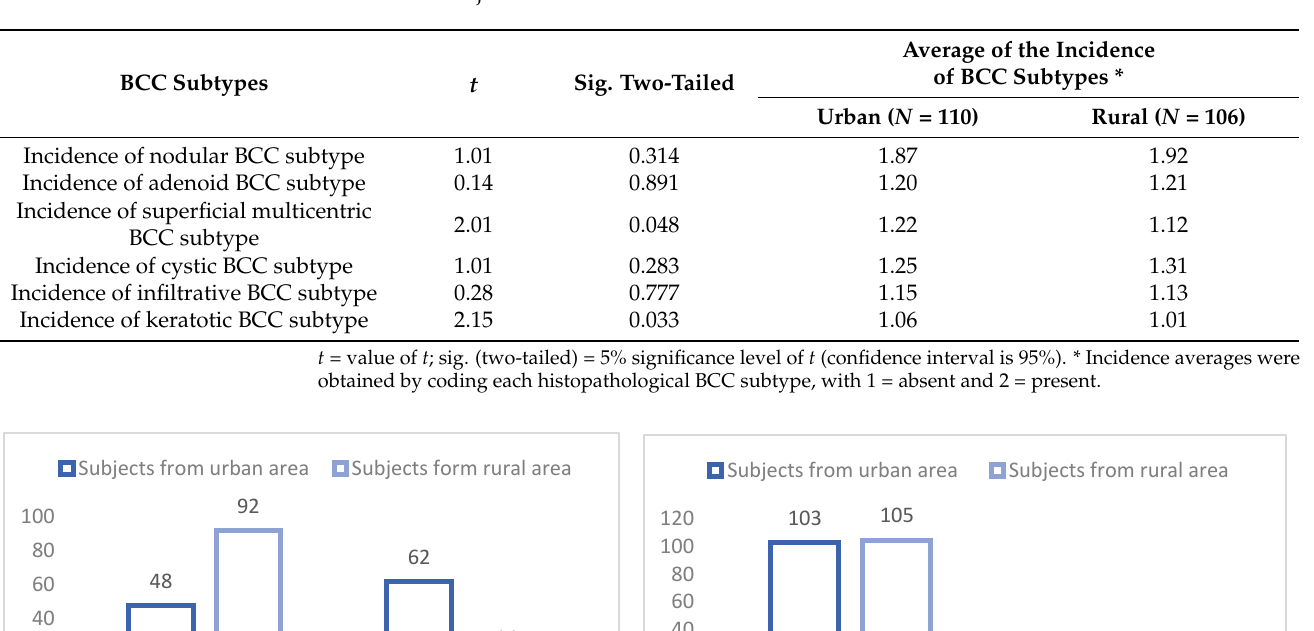
Table 6. Comparison of the incidence of the six histopathological BCC subtypes depending on whether the subjects were from an urban or rural environment.